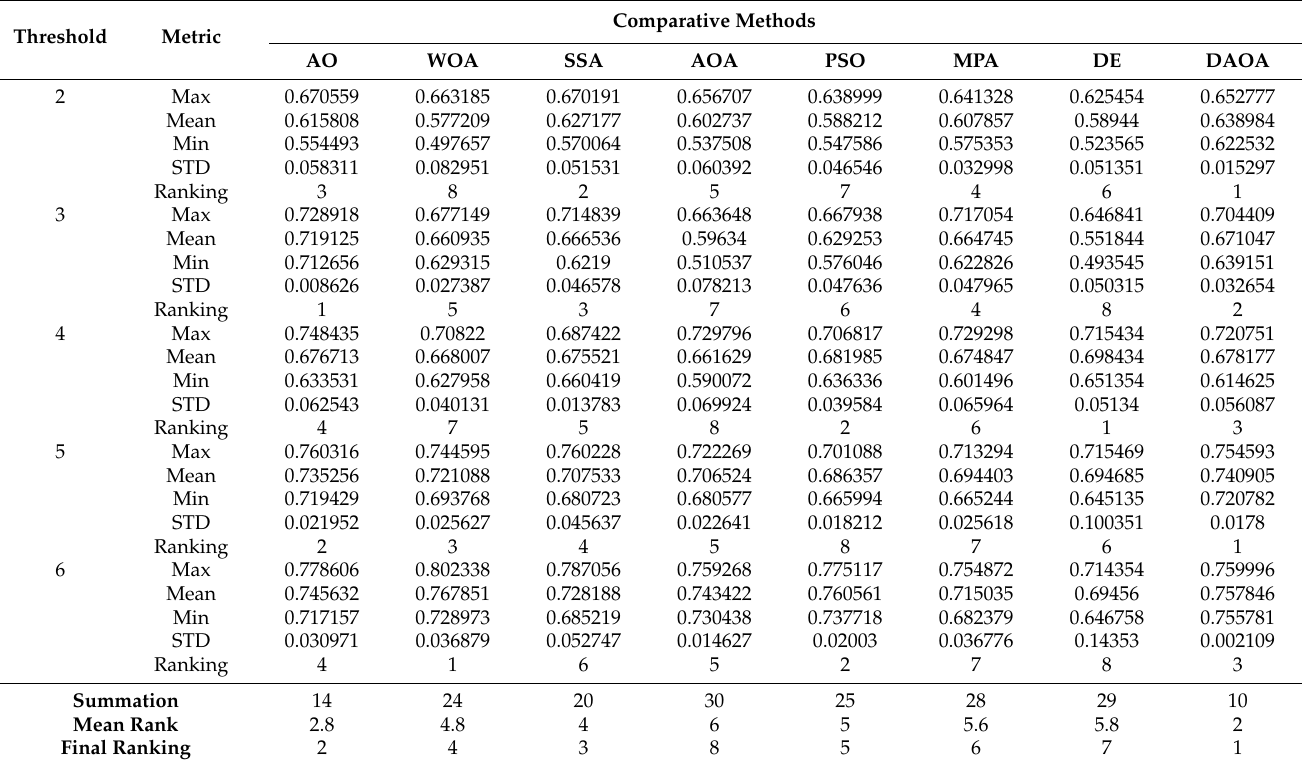
Table 11. The SSIM results of the test case